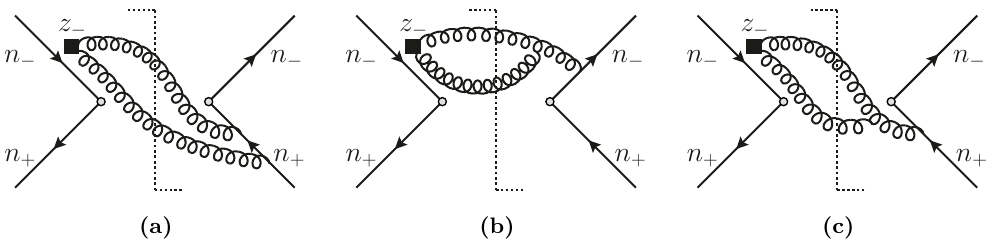
Figure 2. Diagrams contributing to the S 3 soft function. Same conventions as in figure 1 are used. Here, the filled square stands for the soft covariant derivatives and the Wilson lines contained (cid:2) (cid:2) (cid:3)(cid:3) in 1 B + µ ⊥ , in − ∂ B + . µ ⊥ ( in − ∂ ) 2